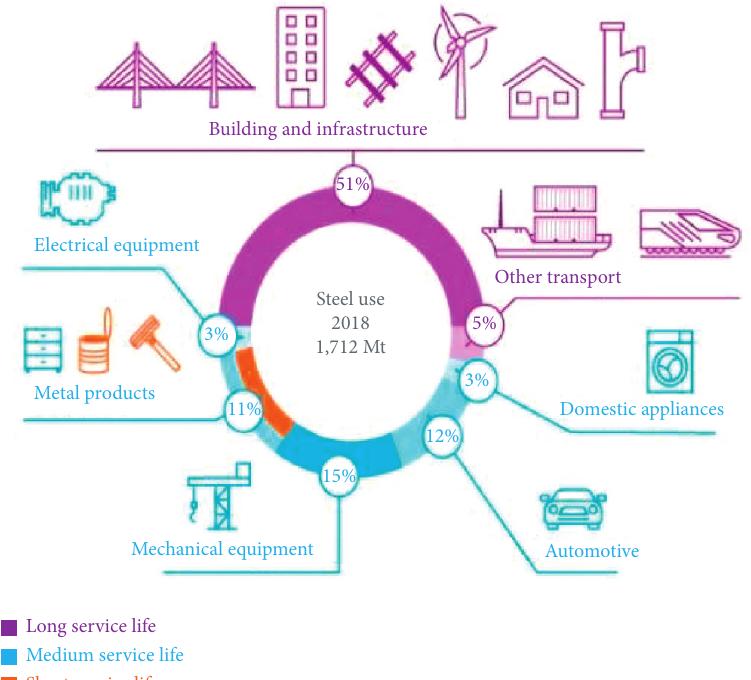
Figure 1: Conception of Steel in various applications. Reprinted with permission of World Steel Association